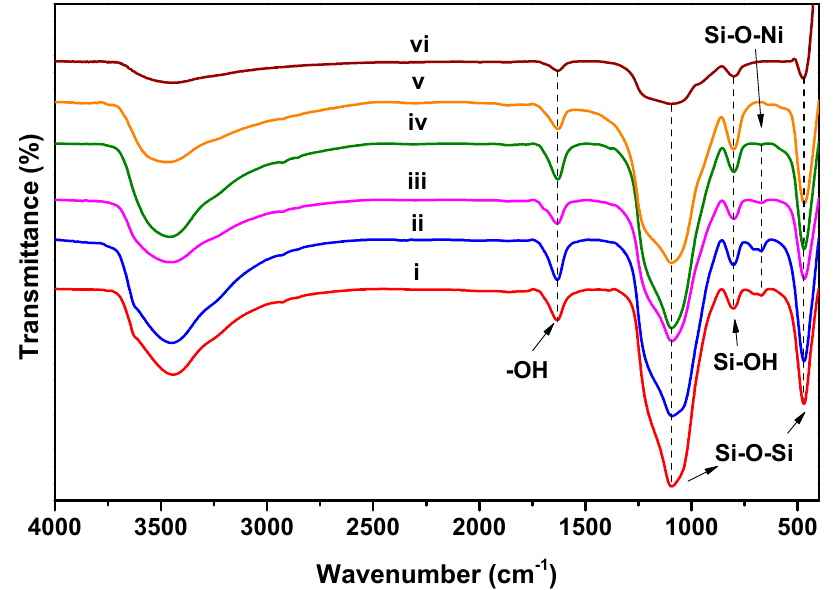
Figure 2. FTIR spectra of reduced catalysts ( i ) Ni 20 /m − SiO 2 , ( ii ) Ni 15 Cu 5 /m − SiO 2 , ( iii ) Ni 10 Cu 10 /m − SiO 2 , ( iv ) Ni 5 Cu 15 /m − SiO 2 , ( v ) Cu 20 /m − SiO 2 , and ( vi ) Ni 5 Cu 15 /C − SiO 2 . Temperature-programmed desorption (TPD) of adsorbed NH 3 as a base probing